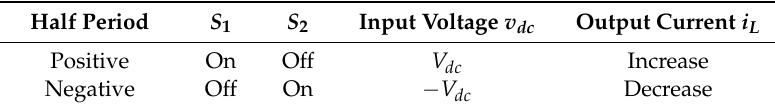
Figure 2. Structure of the digital control system. Table 1. States of switches and corresponding outputs.